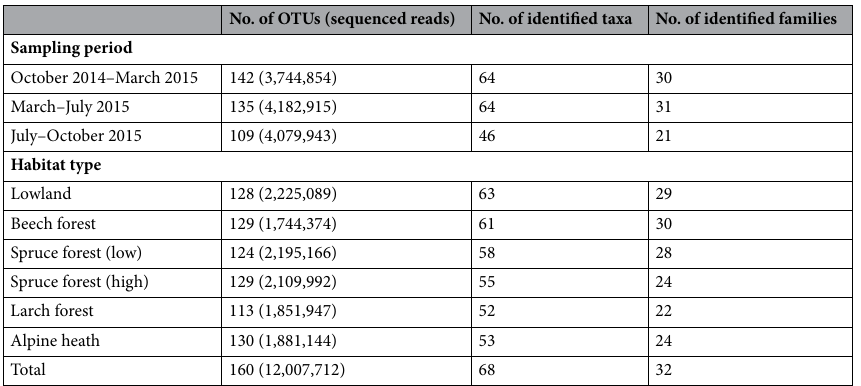
Table 2. Quantitative data for the sequenced reads and the vascular plant taxa that were identified at the different sampling periods and habitats. The full names of the corresponding habitats are given in this table.